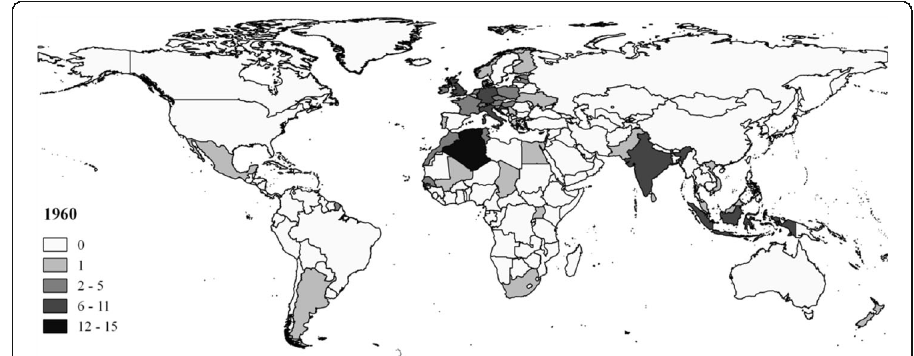
Fig. 1 Absolute no. of foreign athletes by country of birth (1960). Source: Authors ’ calculations and presentation